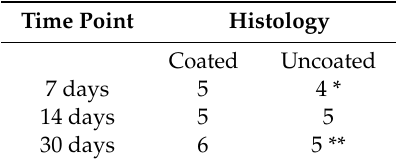
Table 1. The table shows how many animals were evaluated. Time Point Histology